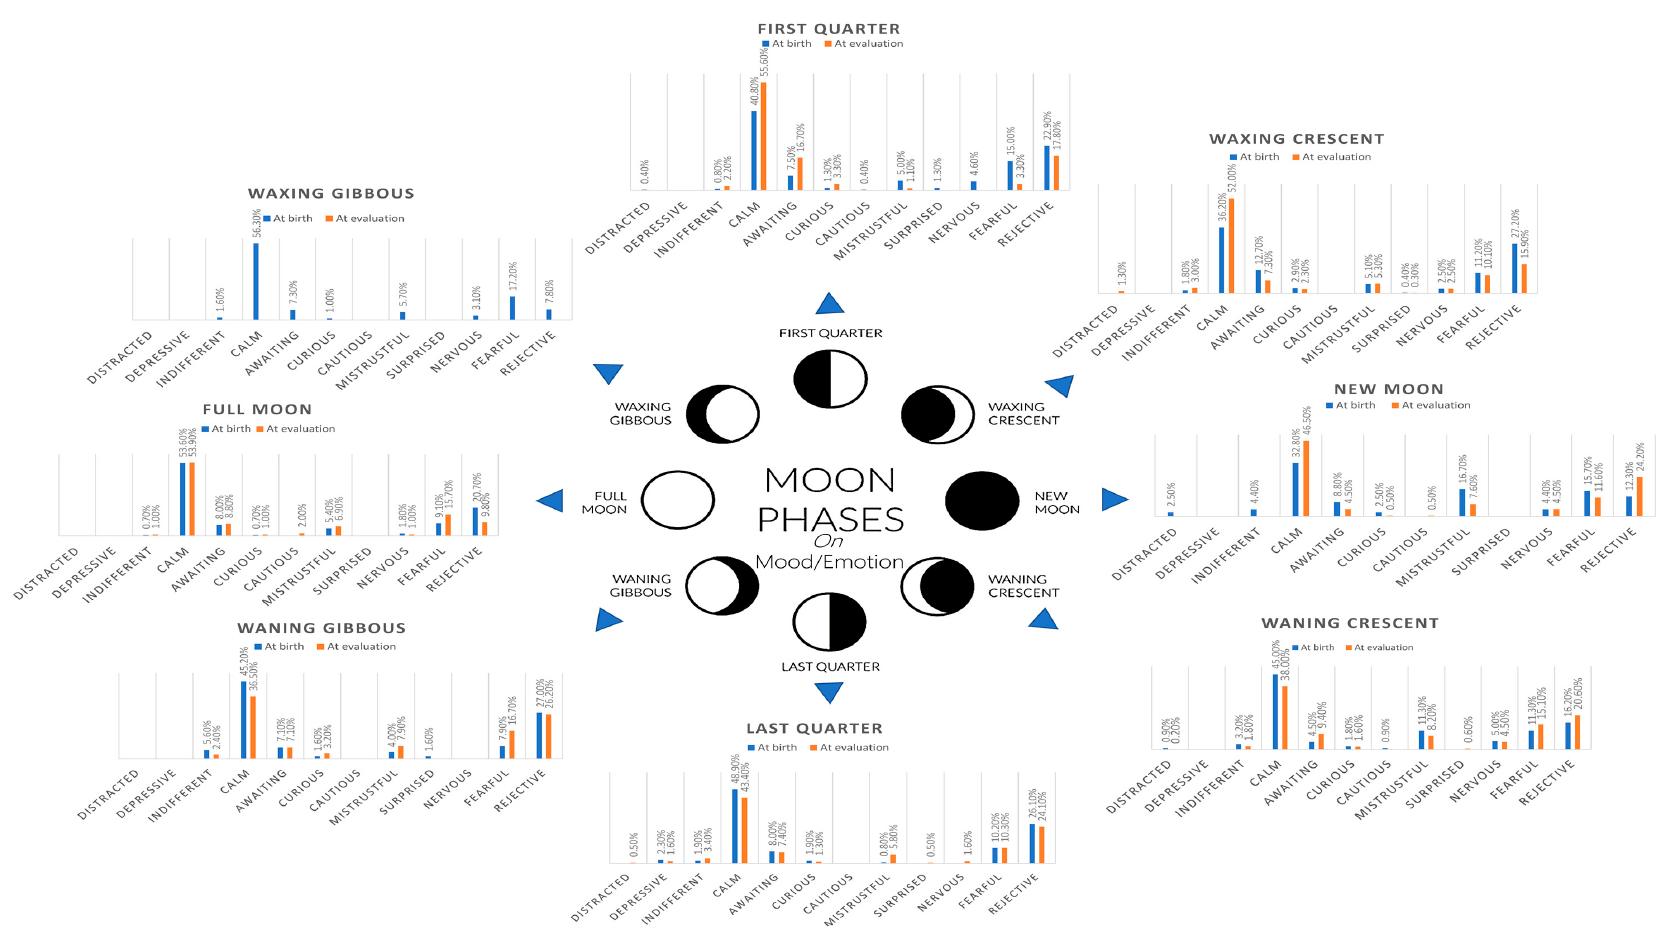
Figure 1. Relative frequency distribution for different mood/emotion patterns displayed by the donkeys relative to the phase of the moon at the moment of birth and at the time of evaluation.